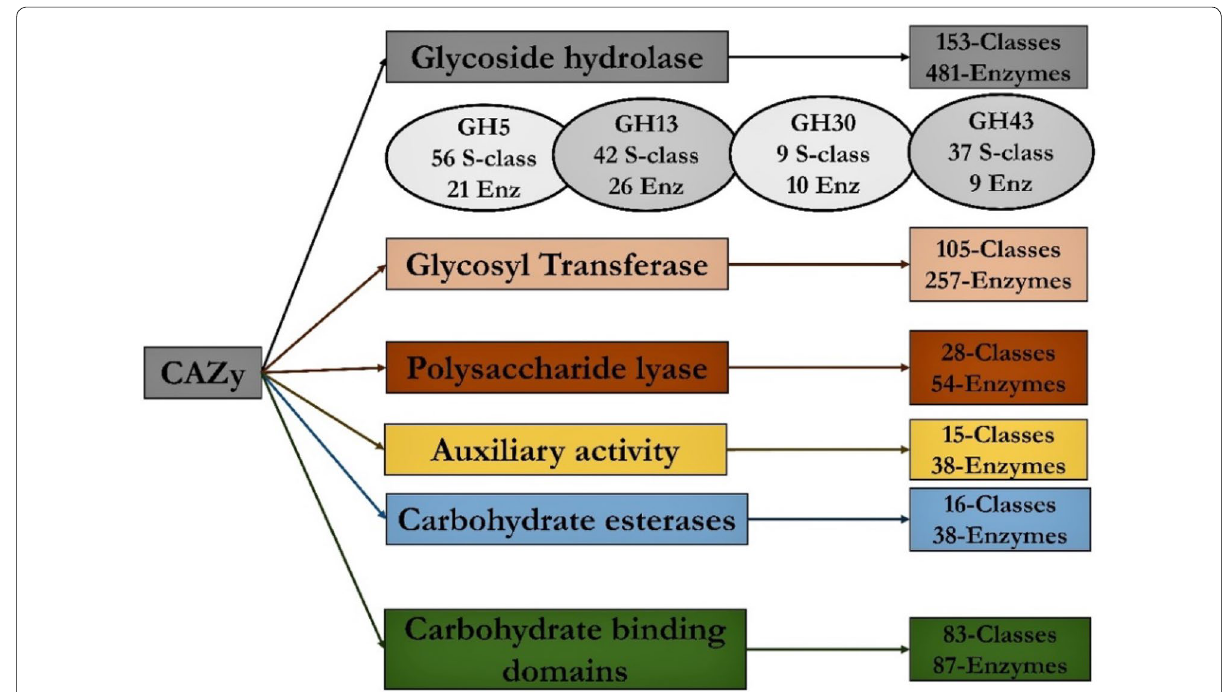
Fig. 1 Illustration of present day’s CAZy database and distribution of enzymes among the different CAZy clans and CAZy